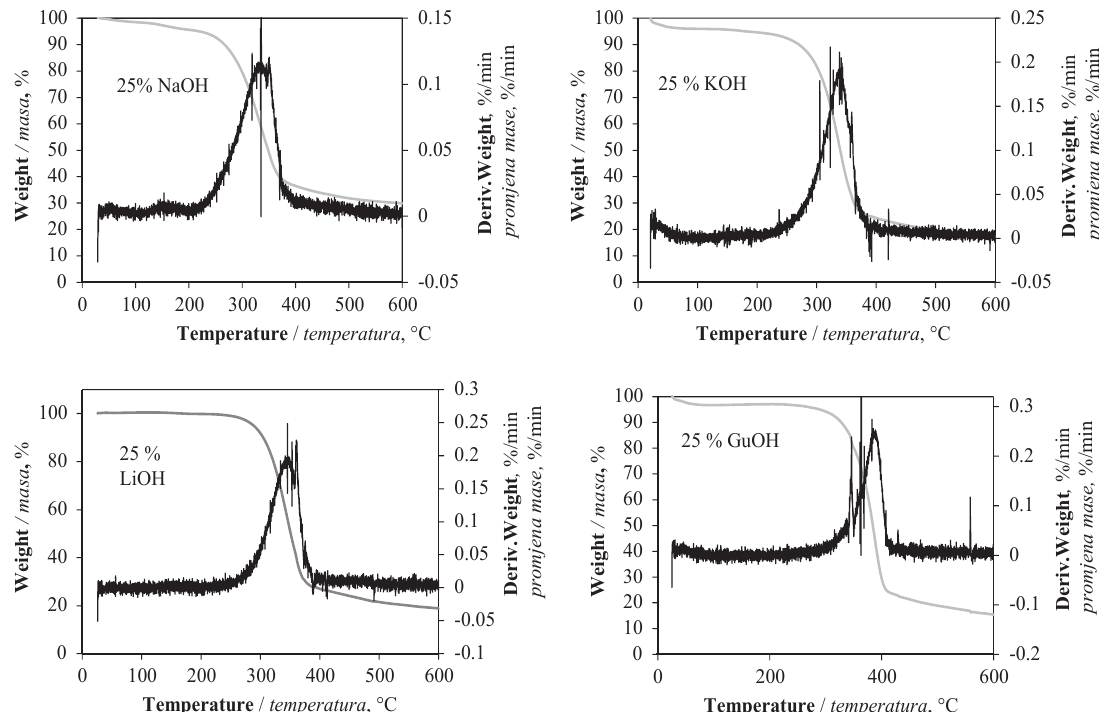
Figure 8 DTG thermograms of benzylated materials under different alkali concentrations Slika 8 . DTG termogrami benziliranog materijala pri razli č itim koncentracijama